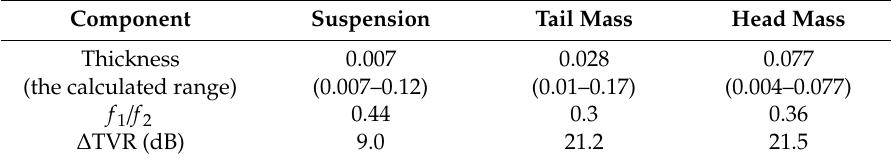
Table 3. Summary of the parameters for minimizing the peak TVR difference between f 1 and f 2 .